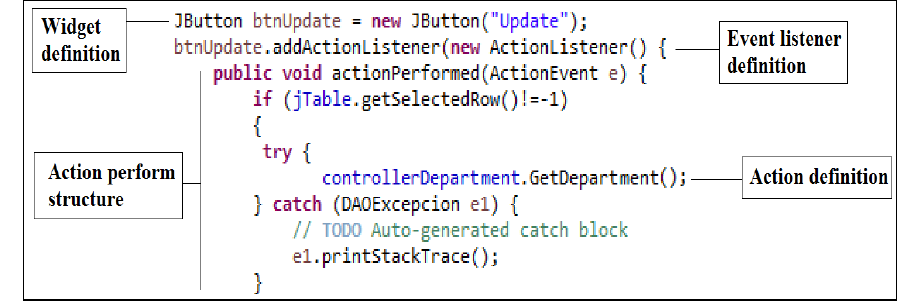
Figure 11. SWT components to define